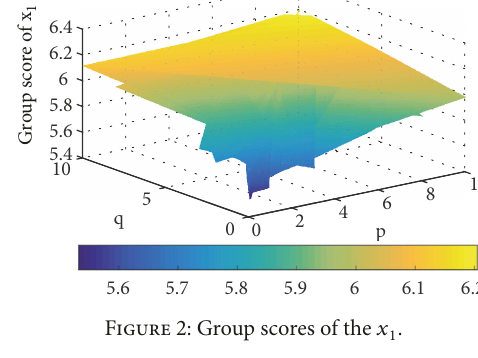
Figure 2: Group scores of the 𝑥 1 .